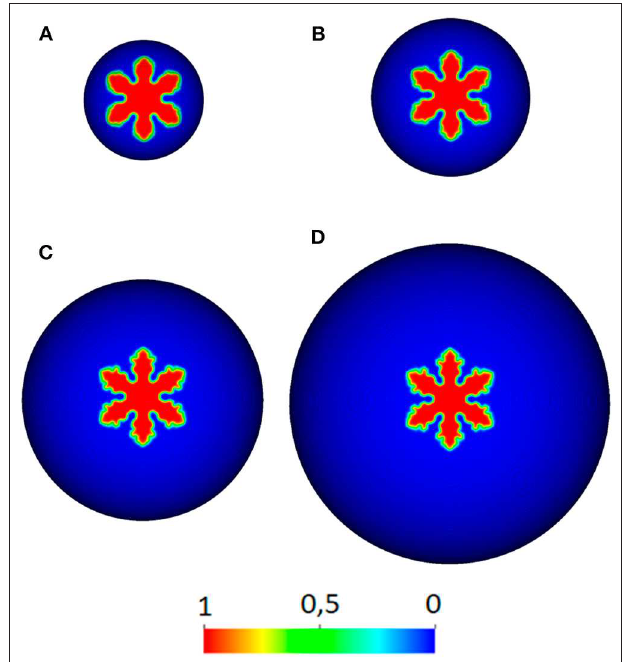
FIGURE 3 | Shape of dendrites as a function of curvature. This figure compares the shape of dendrites grown on substrates of different curvature. Panels (A–D) correspond to crystallites grown on substrates of radius a 1.5,2,3,4, respectively. Note that for small substrates (higher curvature) = the dendrites look less ramified. The color bar shows the amplitude of the order parameter φ .